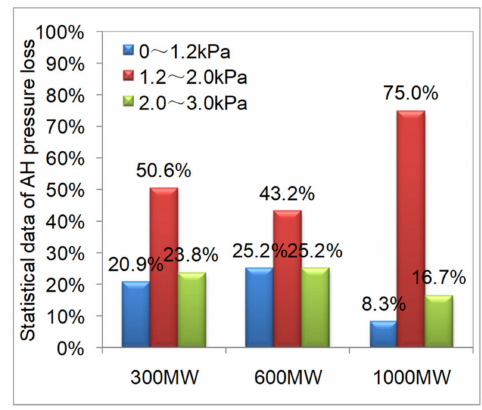
Figure 2. Statistics data of the average air preheater (AH)-resistance in coal-fired